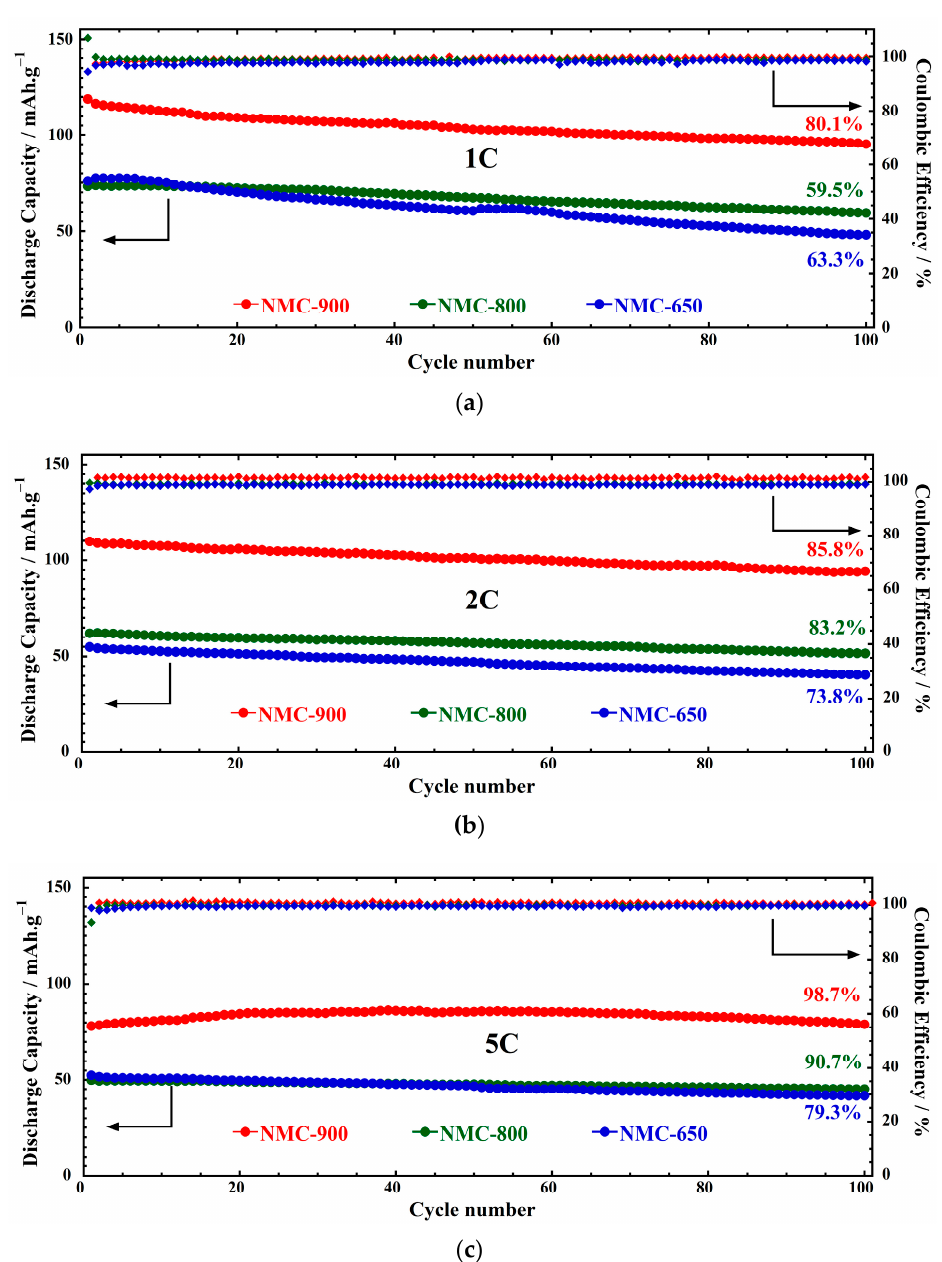
Figure 5. Electrochemical performances of NMC cathodes upon cycle tests in the range of 1.5–4.5 V at ( a ) 1C, ( b ) 2C and ( c ) 5C, respectively.